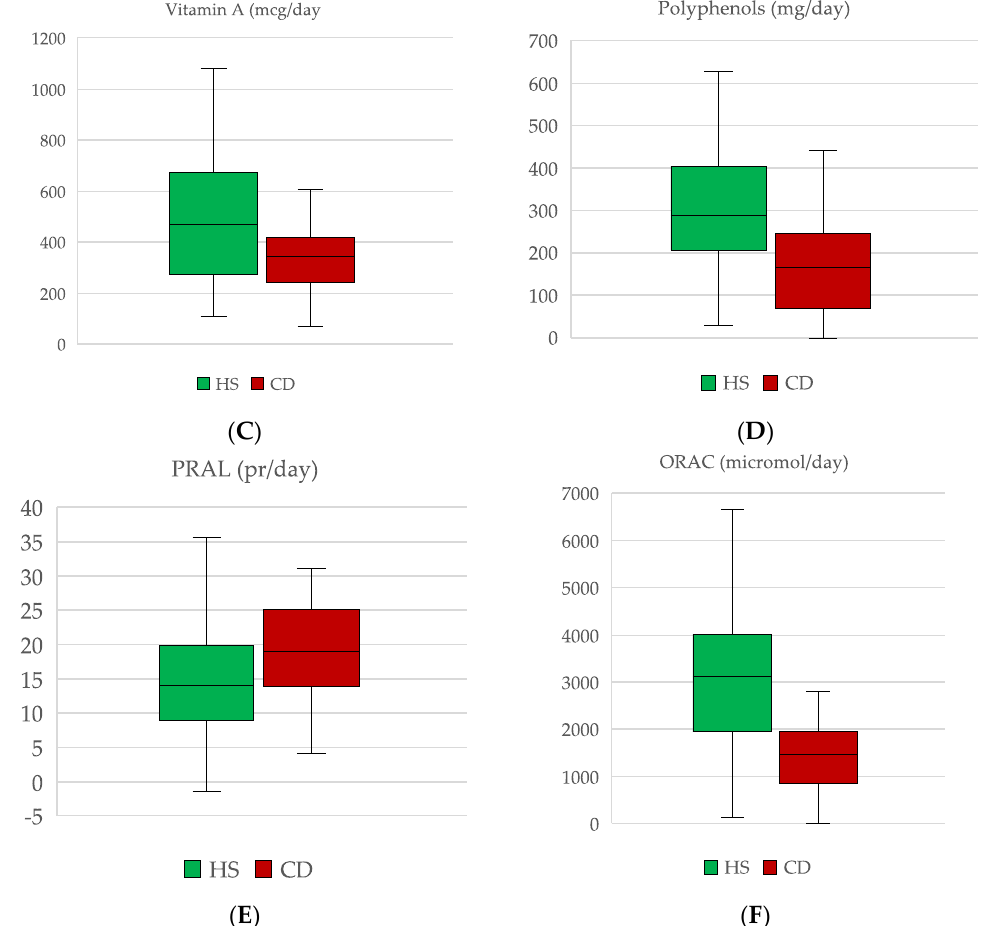
Figure 1. Graphic representation of tbe most relevant statistically significant results. ( A ) Total fibers; ( B ) Animal proteins; ( C ) Vitamin A; ( D ) Polyphenols; ( E ) PRAL; ( F ) ORAC. Boxes represent IQR and horizontal middle lines are medians. Whiskers highlight minimum and maximum values. p -values are mentioned in the text. HS: Healthy subjects. CD: Crohn’s disease. ORAC: Oxygen Radical Absorbance Capacity. PRAL: Potential Renal Acid Load.